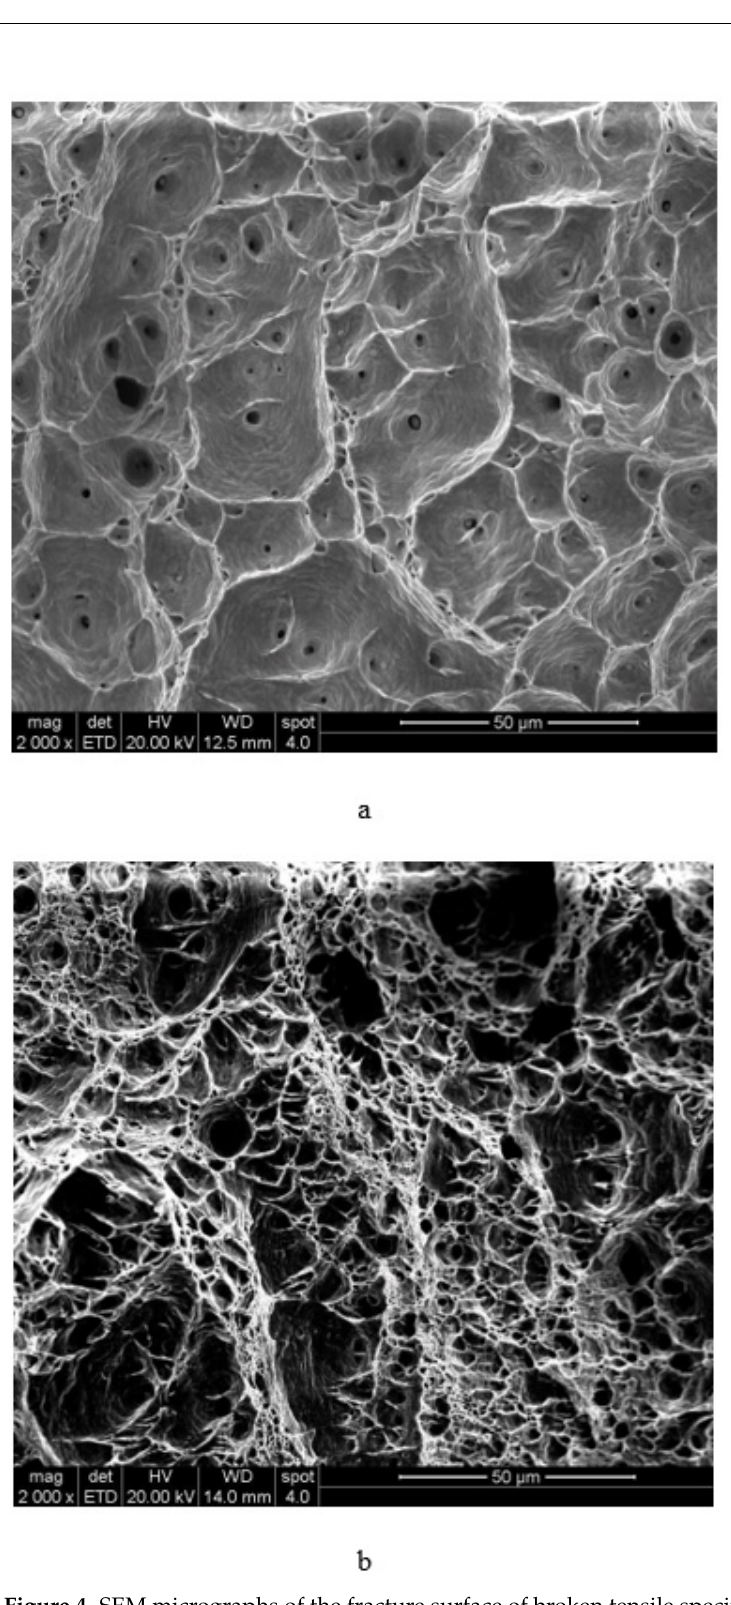
Figure 4. SEM micrographs of the fracture surface of broken tensile specimens: ( a ) parent material; ( b ) friction-stir-processed (FSP’ed) specimen. Figure 5a,b are bright-field (BF) TEM micrographs of the parent material taken near